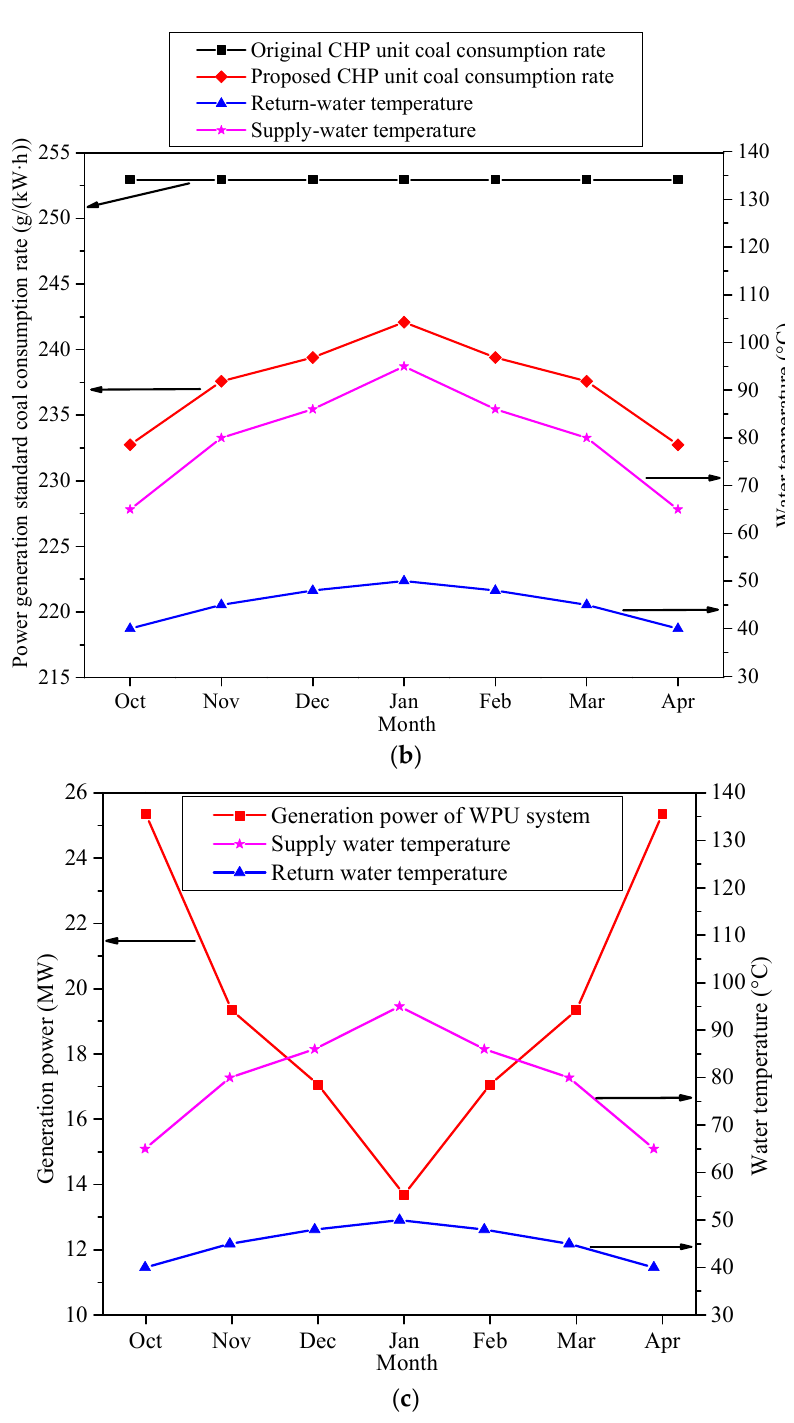
Figure 12. Effect of the supply and return-water temperatures on the thermal performances of the original and improved CHP units (the unit heating load and generation load were set as 200 MW and 250 MW, respectively). ( a ) Power generation thermal efficiency; ( b ) power generation standard coal consumption rate; and ( c ) generation of power of the WPU system.